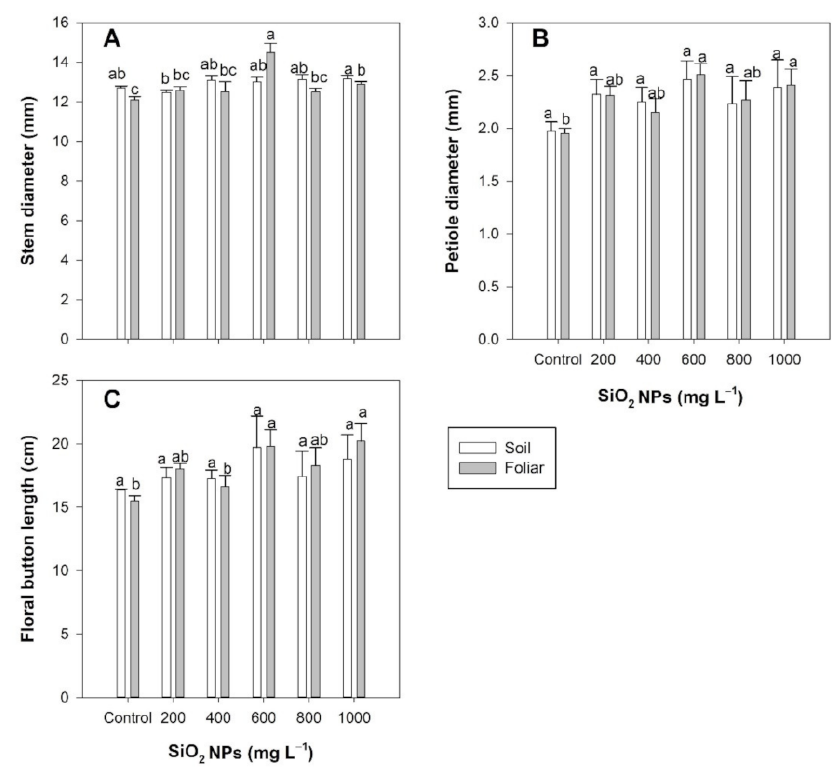
Figure 1. Effect of the application of SiO 2 NPs on the stem diameter ( A ), petiole diameter ( B ), and button length ( C ) of Lilium plants. Different letters indicate significant differences according to Fisher’s least significant difference test ( p ≤ 0.05).